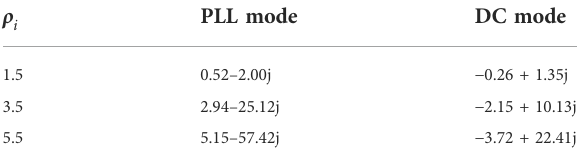
TABLE 2 Computational results of sensitivity index.